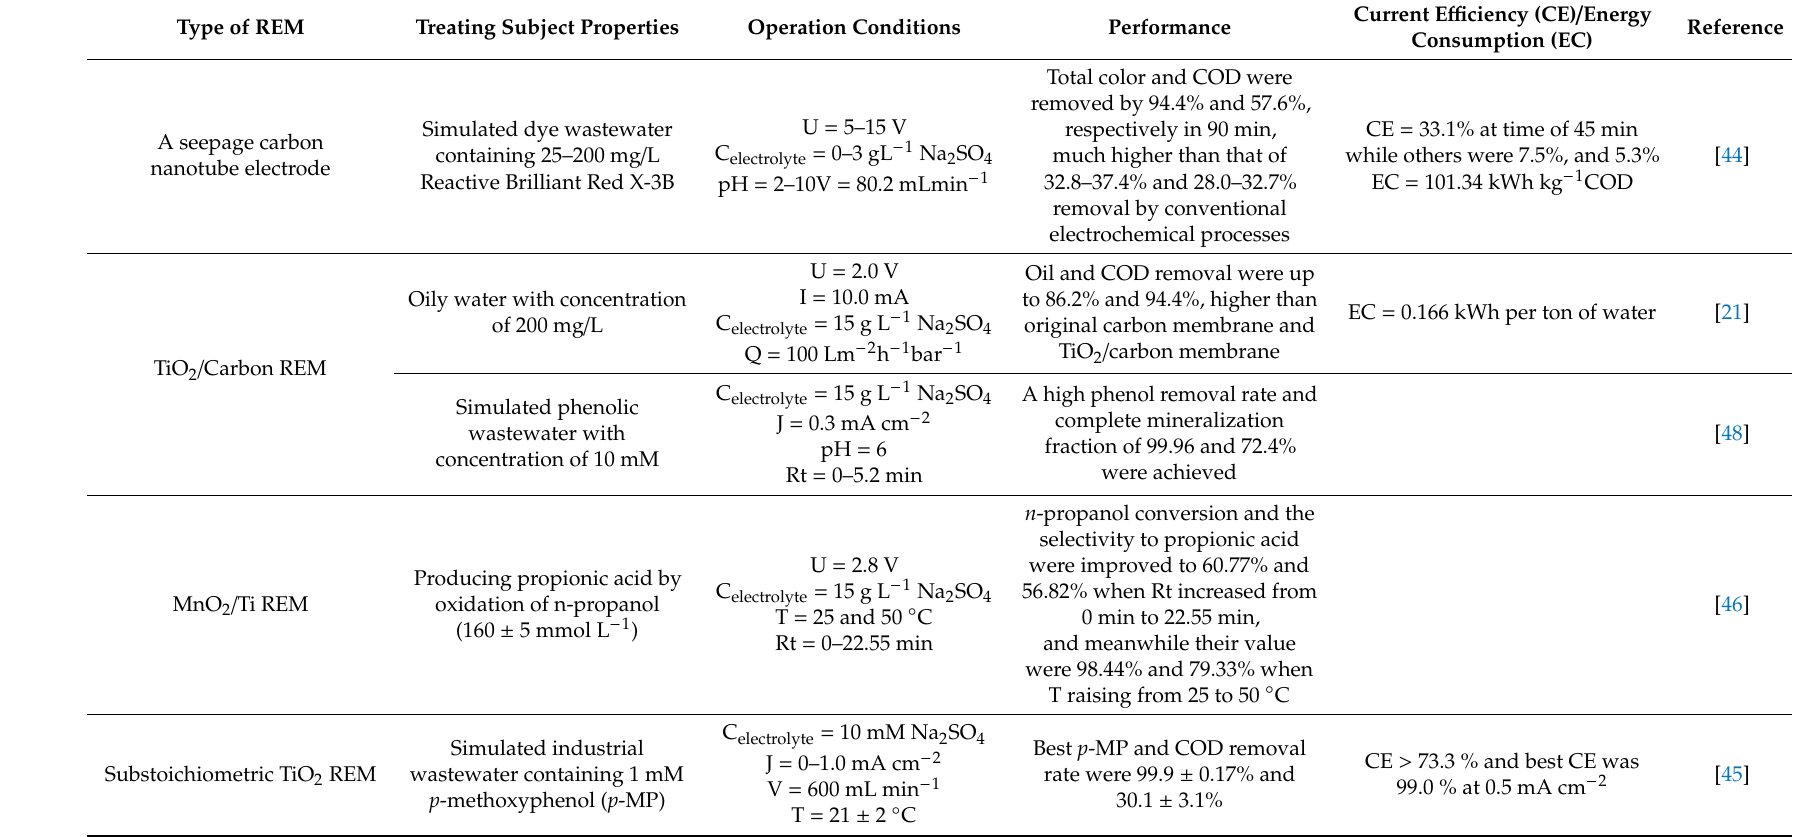
Table 2. Recent studies of application of electrochemical anodic membranes (EAM)